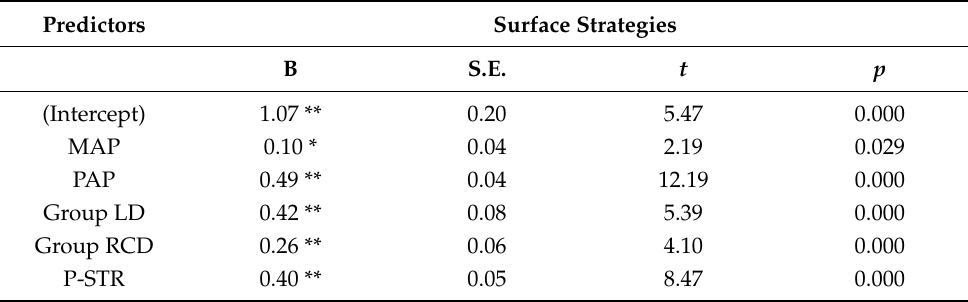
Table 3. Model 5: Linear regression analysis for predicting surface strategies. Predictors